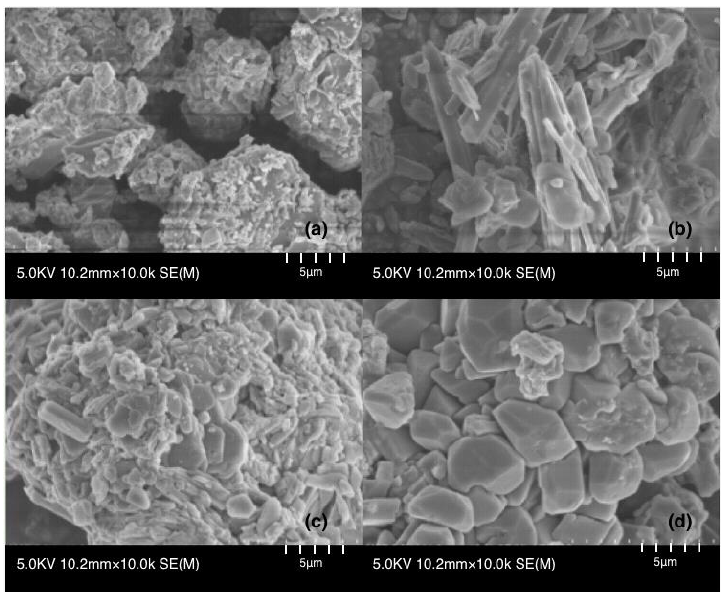
Figure 10. SEM Images: ( a ) PSAFS SEM image; ( b ) Mn-PSAFS; ( c ) Zn-PSAFS; ( d ) Mg-PSAFS.